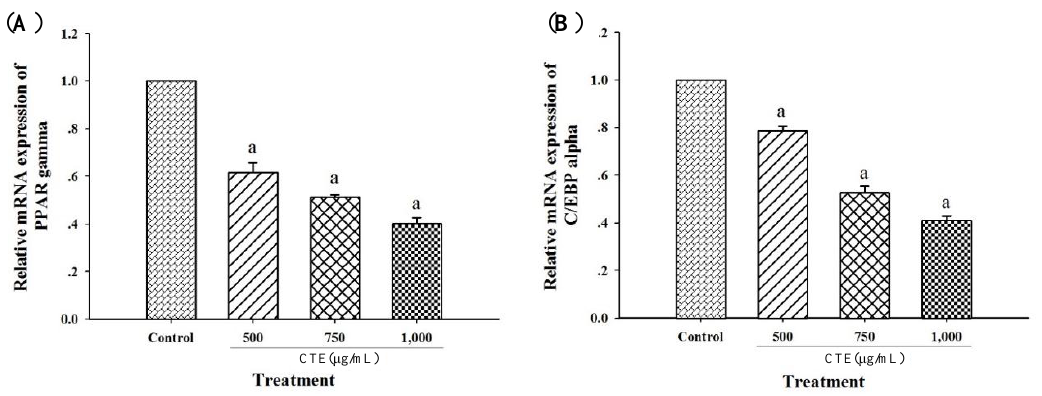
Figure 7. Effects of CTE on mRNA expression of PPARγ ( A ) and C/EBPα ( B ) of 3T3-L1 cells at day 9. The mRNA expression of PPARγ (A) and C/EBPα (B) are shown in relative values to beta-actin. Each value represents the mean ± SEM ( n = 3). a p < 0.05 compared with the control group.